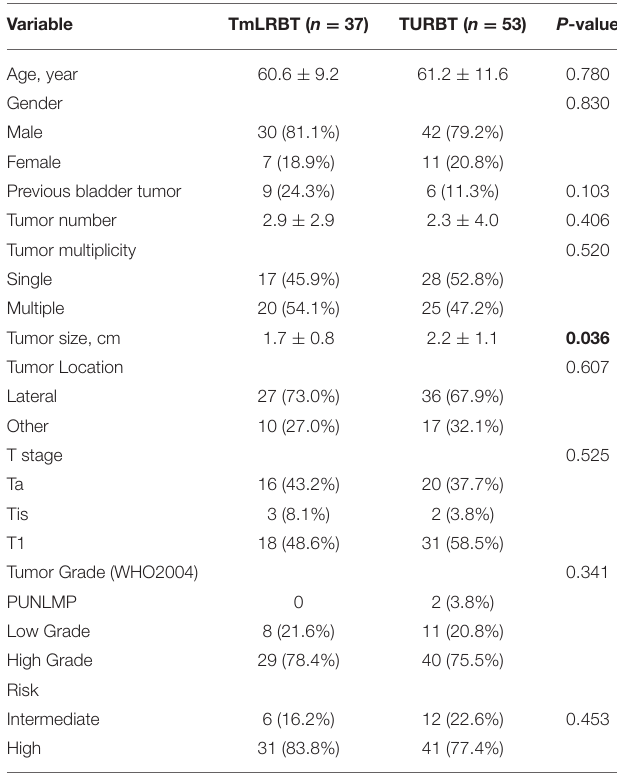
TABLE 1 | Characteristics of included patients and